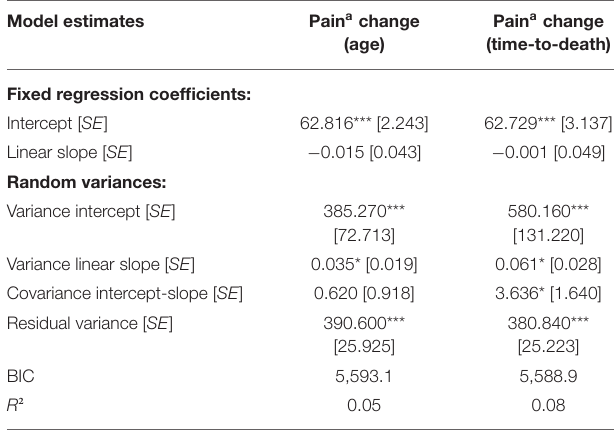
TABLE 2 | Longitudinal multilevel regression models of changes in pain over age and over